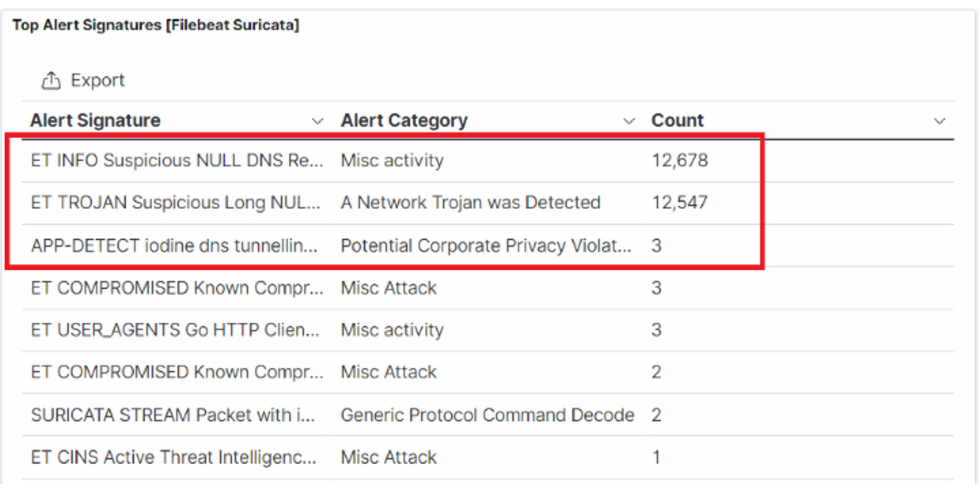
Figure 13. Suricata alerts in the Elastic stack during DNS exfiltration with